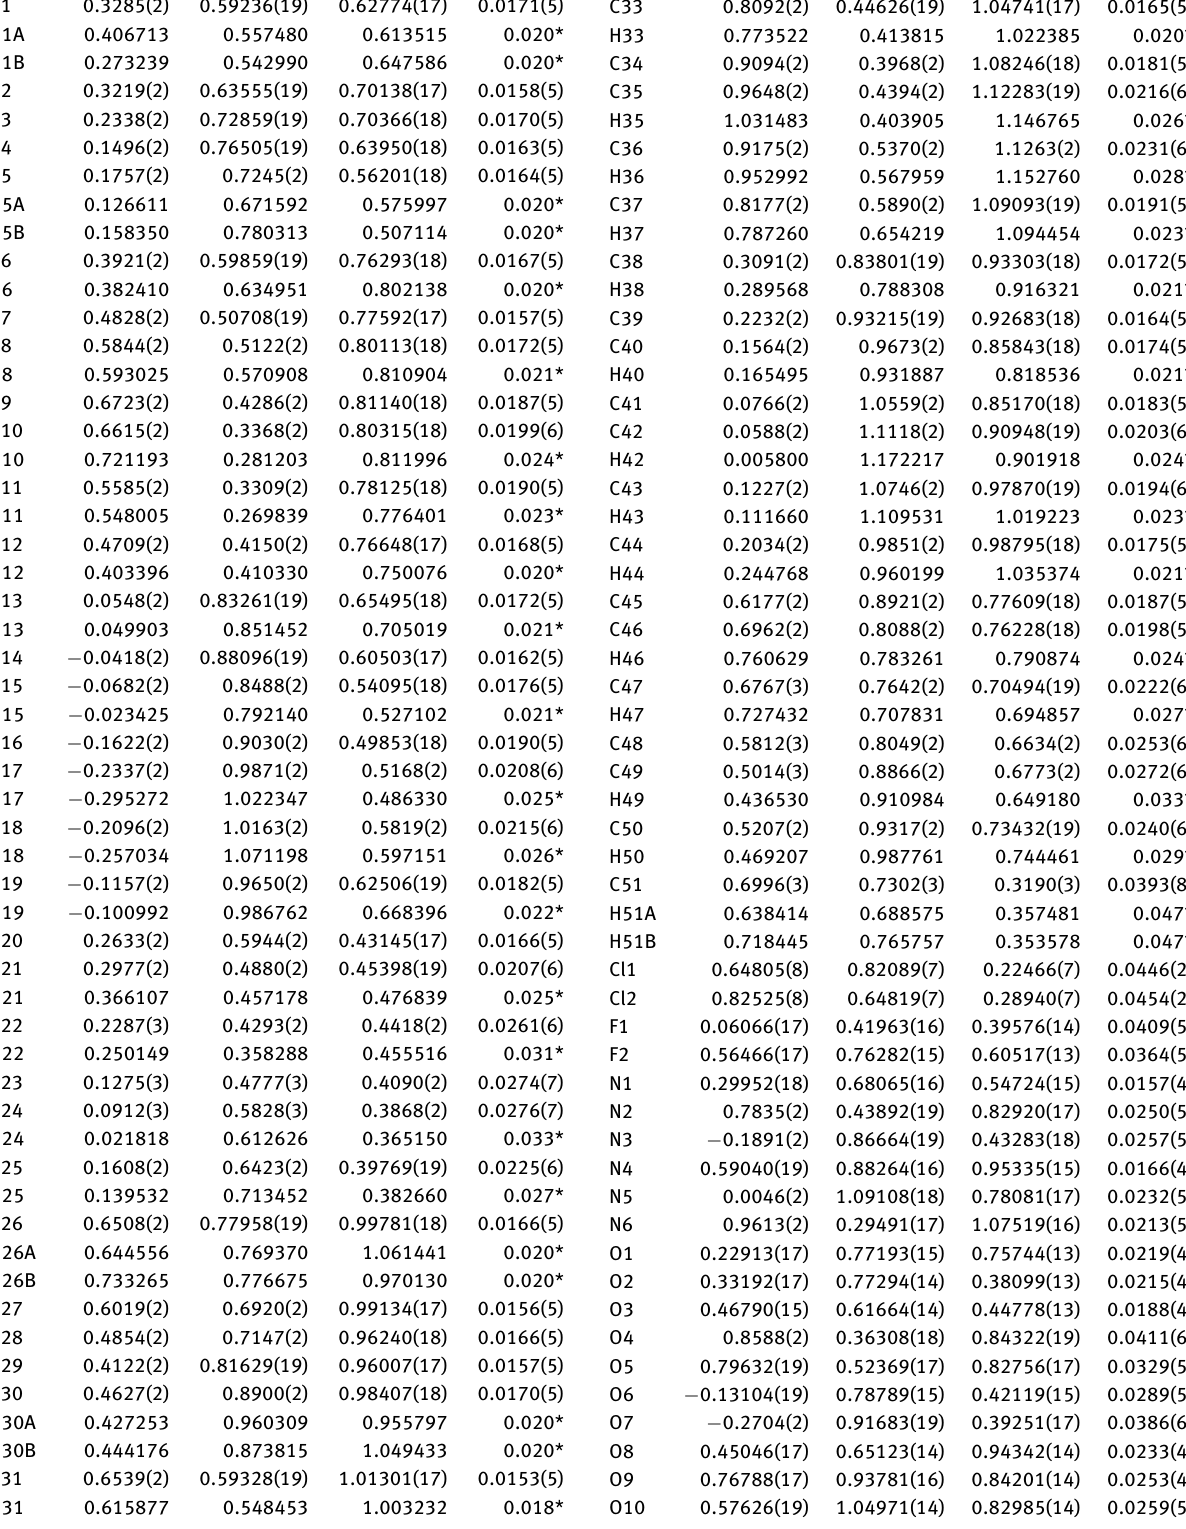
Table 2: Fractional atomic coordinates and isotropic or equivalent isotropic displacement parameters (Å 2